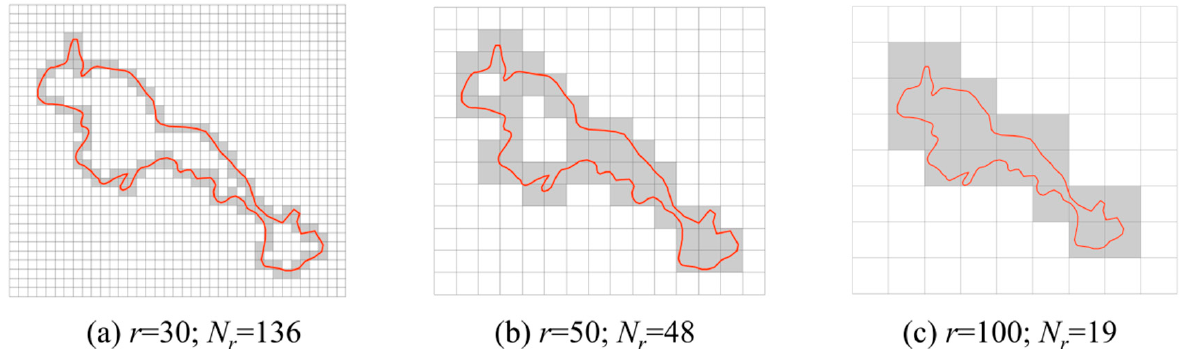
Figure 3. The principle of the box-counting method, using different grid sizes, i.e., ( a ) 30 m; ( b ) 50 m; and ( c ) 100 m.